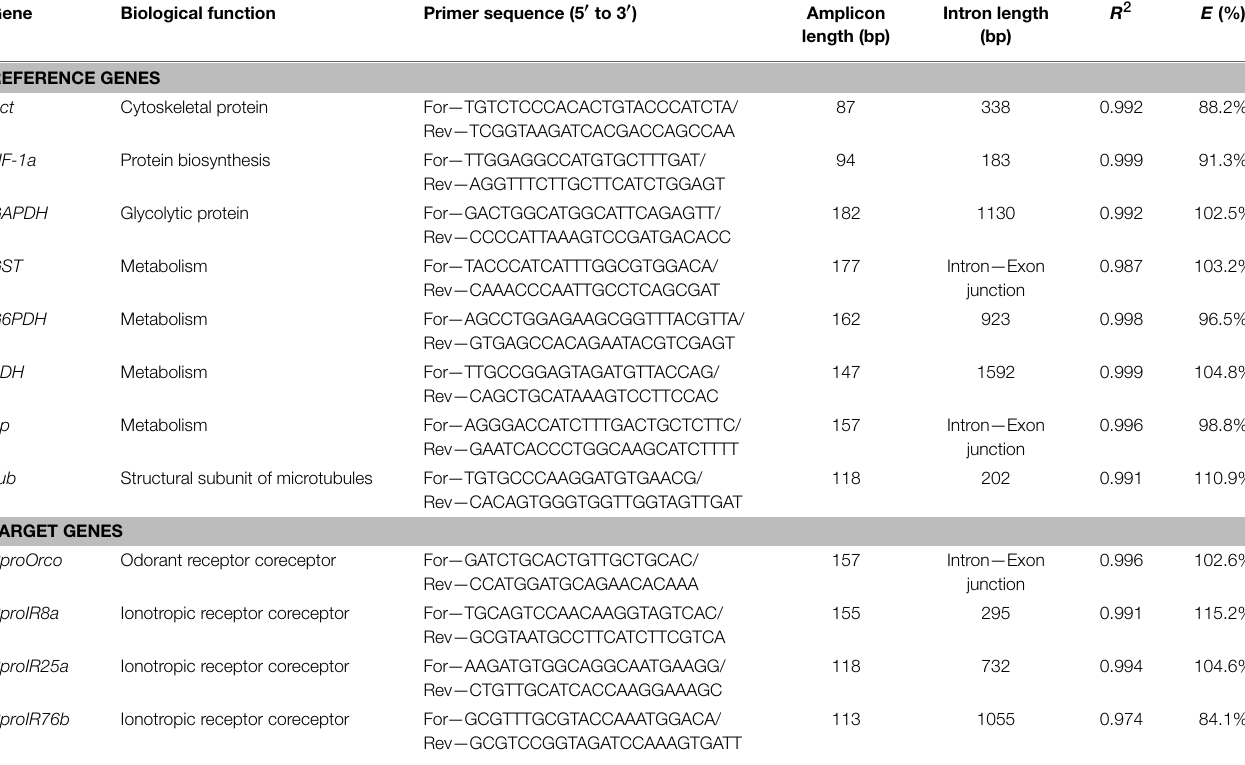
TABLE 1 | Reference and target genes, biological function, primer sequences, amplicon and intron lengths, squared correlation coefficient, and qRT-PCR